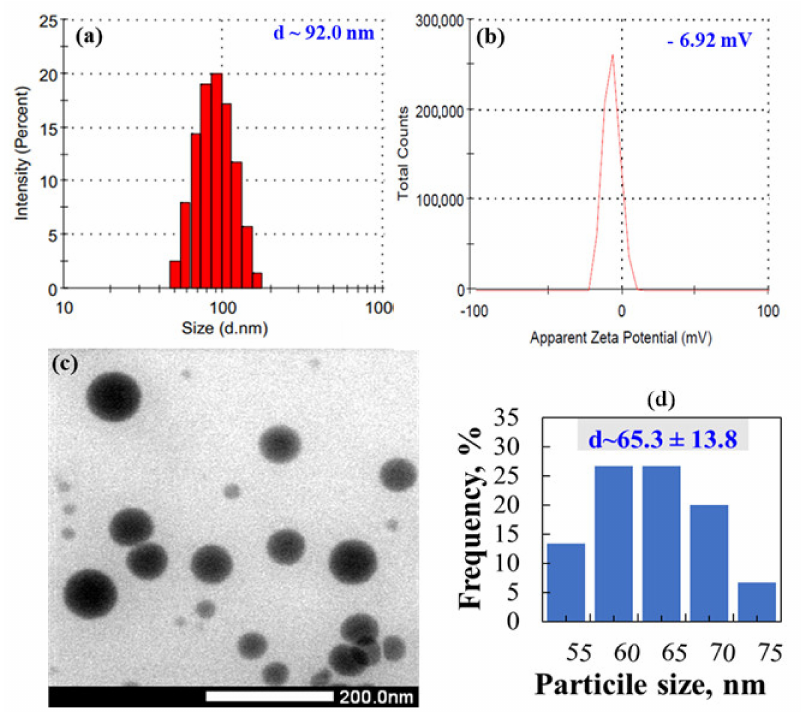
Figure 5. Particle size, size distribution ( a ) and zeta potential ( b ) TEM image ( c ) and size distribution histogram ( d ) of SeNPs/ β -glucan synthesized by gamma irradiation at dose of 8 kGy and dose rate of 10 kGy h − 1